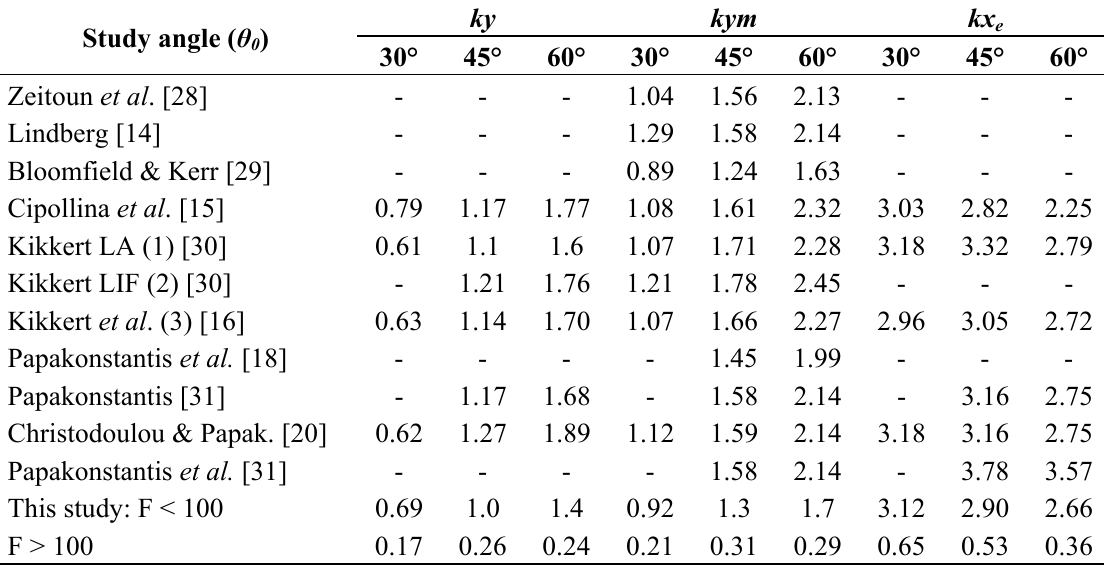
Table 2. Coefficient values describing the linear dependence of normalized